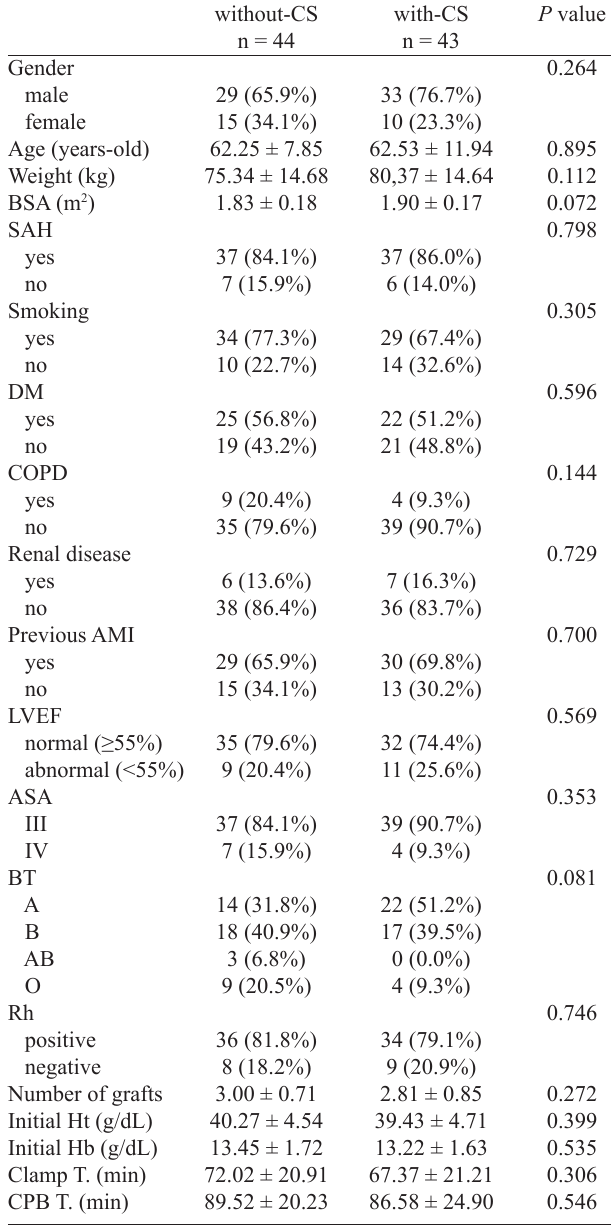
Table 1. Patients’ profile stratified by